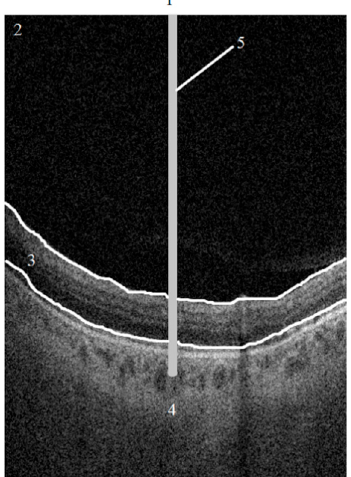
Figure 2. The structure of the retina as it pertains to laser exposure: 1—edge conditions, 2—vitreous, 3—retina, 4—vascular layer, 5—laser radiation.